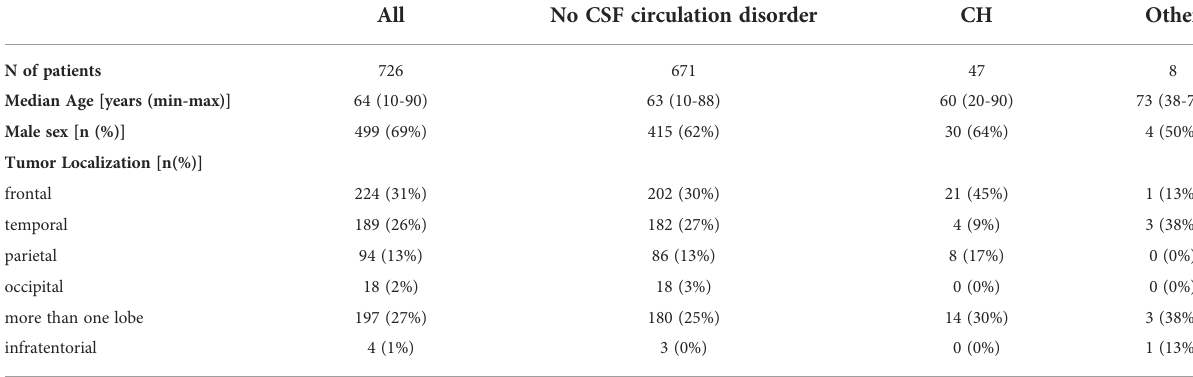
Table 1 Characteristics of GBM patients with and without CSF circulation disorders.